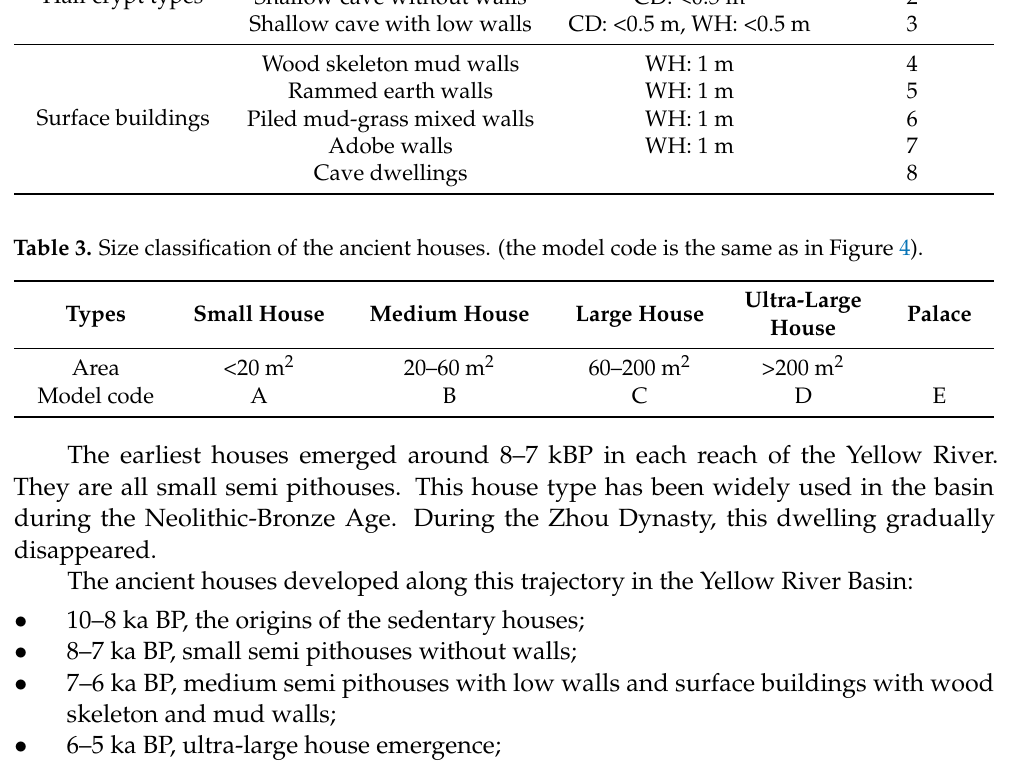
Table 2. Form categories of the ancient houses (CD = cave depth; WH= wall height; the model code is the same as in Figure 4). Form Shape and Structure Character Model Code Deep cave without walls CD: >0.5 m 1 Half crypt types Shallow cave without walls CD: <0.5 m 2 Shallow cave with low walls CD: <0.5 m, WH: <0.5 m 3 Wood skeleton mud walls WH: 1 m Rammed earth walls Surface buildings